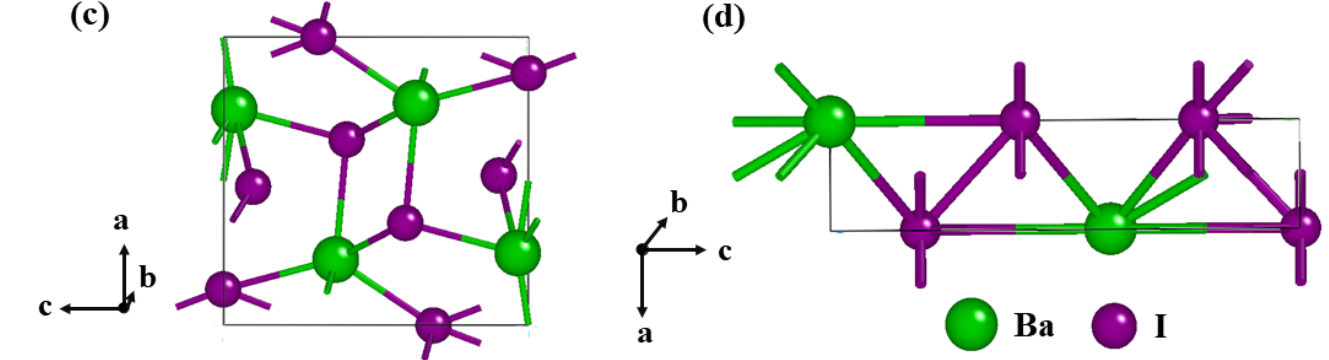
Figure 1. ( a ) Enthalpies (related to the Pnma phase) of Cmcm , P6 3 / mmc and I 4/ mmm structures of BaI 2 . The former reported P 112 1 / a structure 13 is thermodynamically unstable. ( b ) The relative volume of BaI 2 . The crystal structure of orthorhombic Pnma ( c ) and tetragonal I 4/ mmm ( d ) of BaCl 2 at 0.3 and 17.1 GPa, respectively.